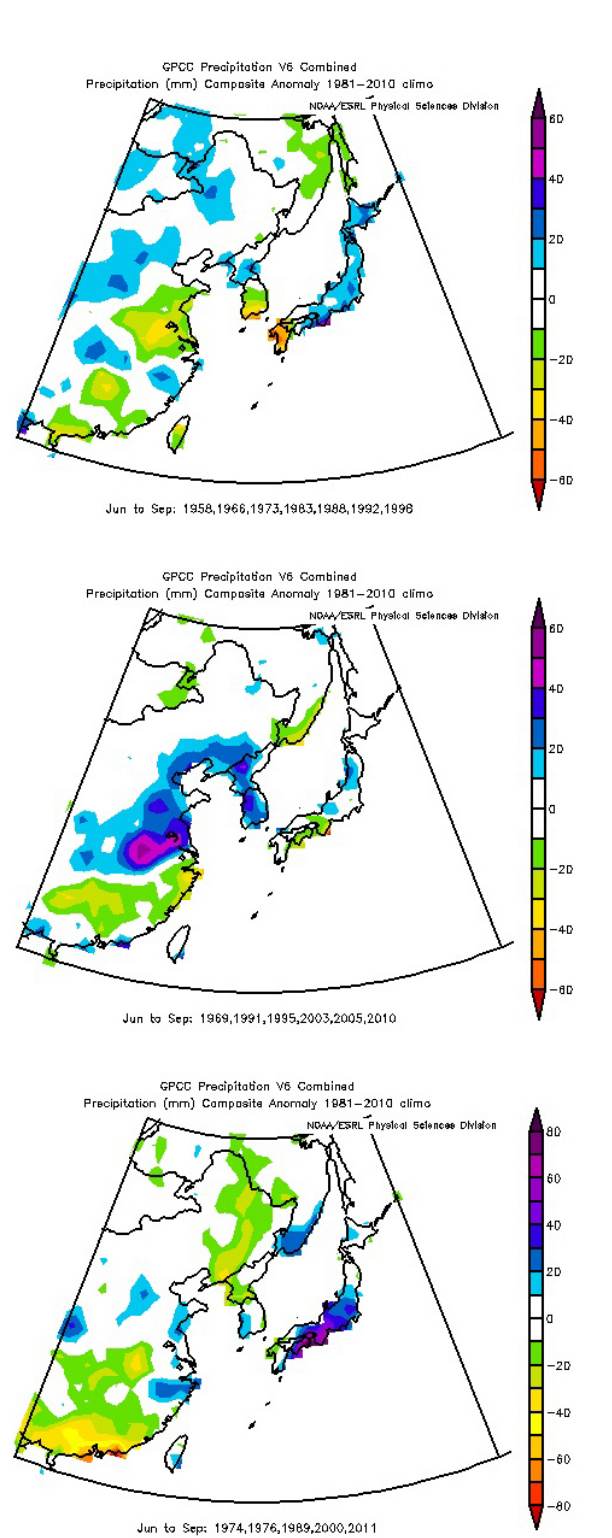
Figure 3. Composite anomalies (1981–2010 climatology) of GPCC Full V6 combined precipitation (JJAS: June to September) during ENSO events over the North East Asia